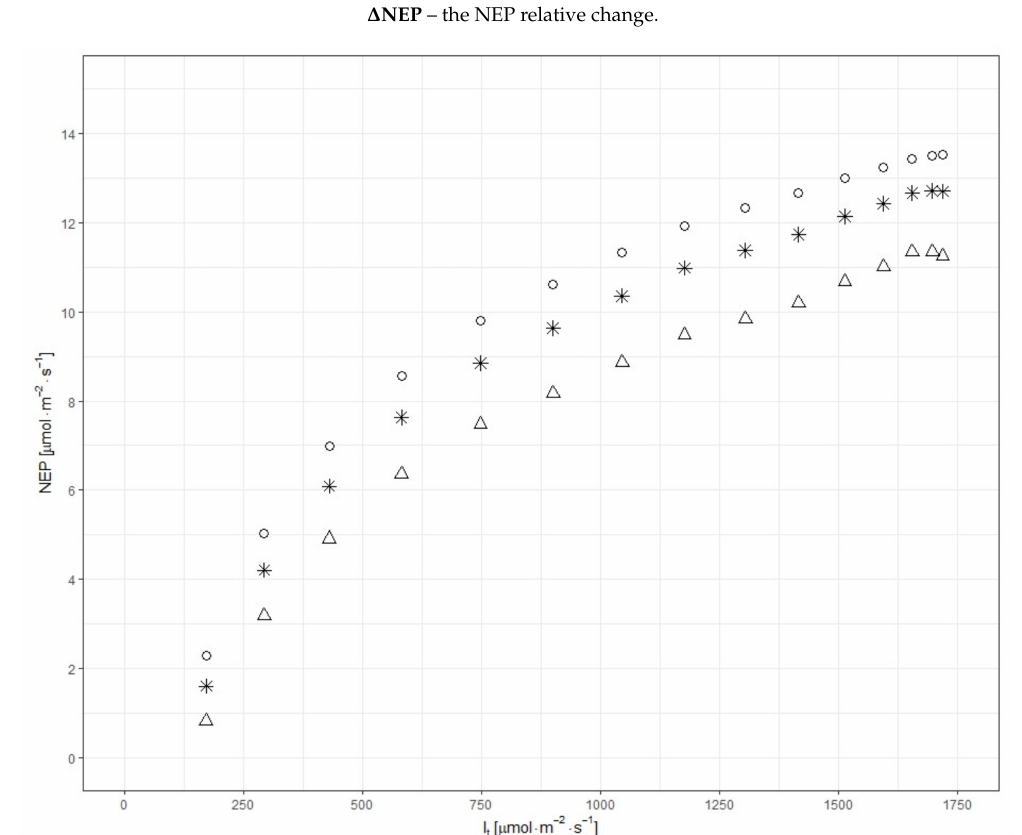
Figure 7. Net ecosystem production (NEP) vs. total photosynthetic photon flux density (It) of Rzecin peatland calculated for conditions of June 23rd, 2016 (175th day of year). There were three different values of DI applied: measured DI (asterixis), DI-0.1 (triangles), DI + 0.1